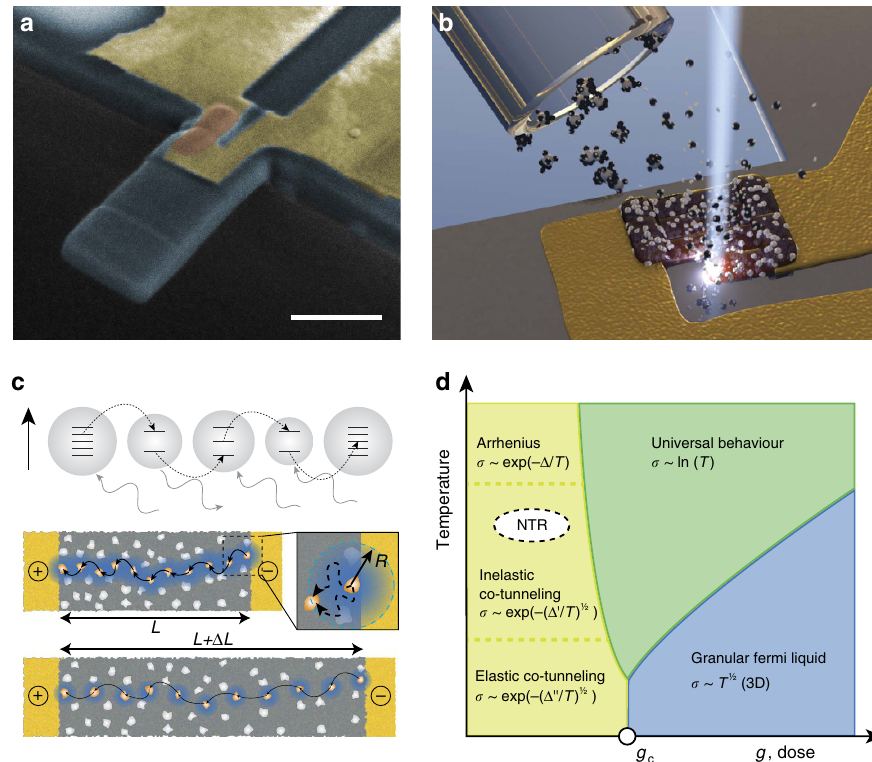
Figure 1 | Fabrication and electronic transport in nanogranular tunnelling resistor sensors. ( a ) Example of nanogranular tunnelling resistor (NTR) deposited on a 1 m m wide, 300nm thick free standing SiN cantilever. The scanning electron microscopy (SEM) image is false coloured to distinguish the NTR sensor (orange) and the metal contacts (yellow). Scale bar, 1 m m. ( b ) Illustration of the NTR electron-beam-induced deposition process. Precursor gas molecules adsorb and diffuse on the surface, where they are dissociated by the scanned electron beam and form platinum clusters embedded in a carbonaceous matrix. ( c ) Schematic depiction of the inelastic co-tunnelling process in the NTR. Electrons tunnel through several grains at the same time via virtual energy levels. The co-tunnelling radius therefore is larger than the inter grain distance (blue halos). When the sensor is stretched, the inter grain distance increases and the co-tunnelling radius decreases that results in an increased resistance. ( d ) Phase diagram of the electronic transport regimes in granular metals. This phase diagram was theoretically predicted based on a recent theoretical investigations 24 and was largely verified experimentally by very recent experiments on Pt(C)-based granular metal samples with finely tuned tunnel coupling g (ref. 25). The conductivity temperature dependence is given for each regime, where D 0 – D 000 are temperature constants that depend on the NTR material properties and conduction regime 22 . At room temperature and the prevailing coupling strength, the NTR sensors operate within the inelastic co-tunnelling